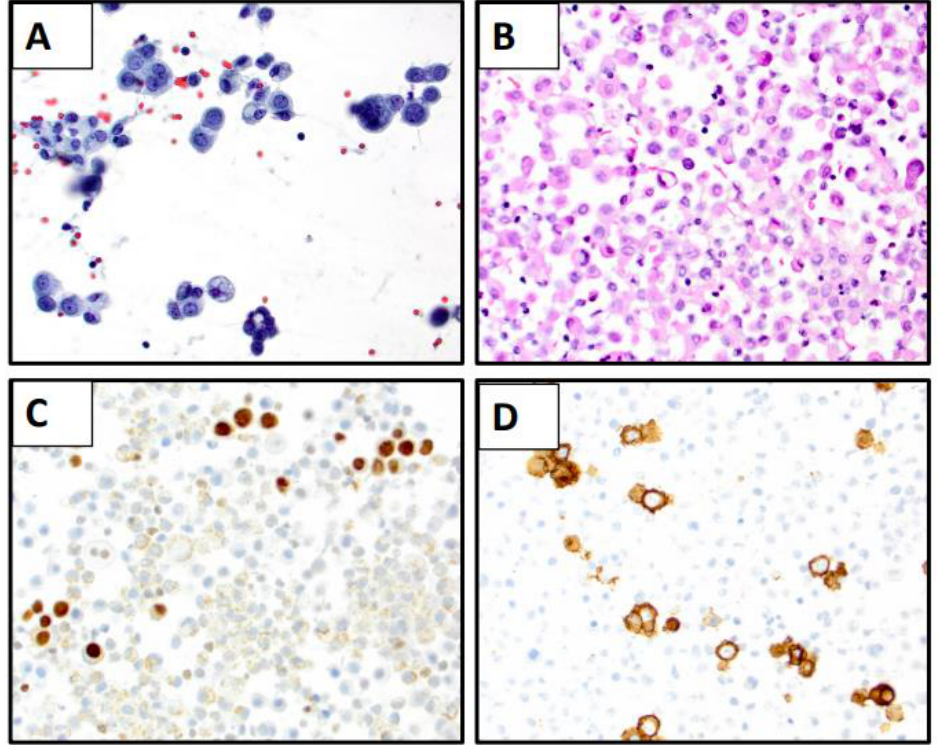
Figure 3. ( A – D ) Metastatic breast cancer in pleural fluid. ( A ) Smear demonstrates